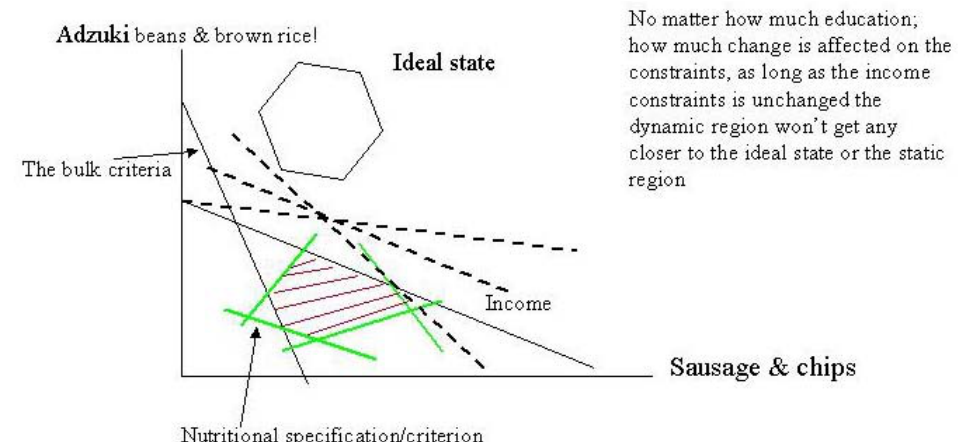
FIGURE 1. The model: free choice vs. constraint